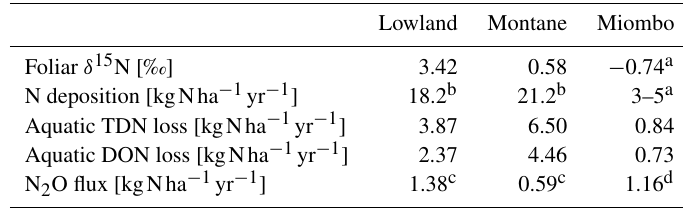
Table 3. Foliar plant δ 15 N [‰] values, N deposition rates [kgNha − 1 yr − 1 ], aquatic TDN, and DON losses [kgNha − 1 yr − 1 ] for the three study sites. Aquatic TDN losses and DON losses are preliminary results from measurements by the authors of this study at the respective study sites (for methods see the